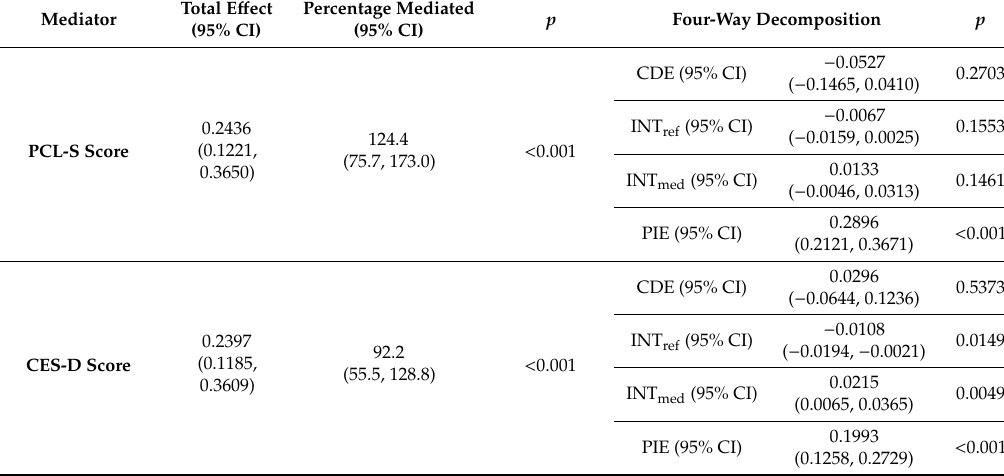
Table 4. Mediators of the association between WTC exposure level and CFI score in FDNY rescue / recovery workers aged ≤